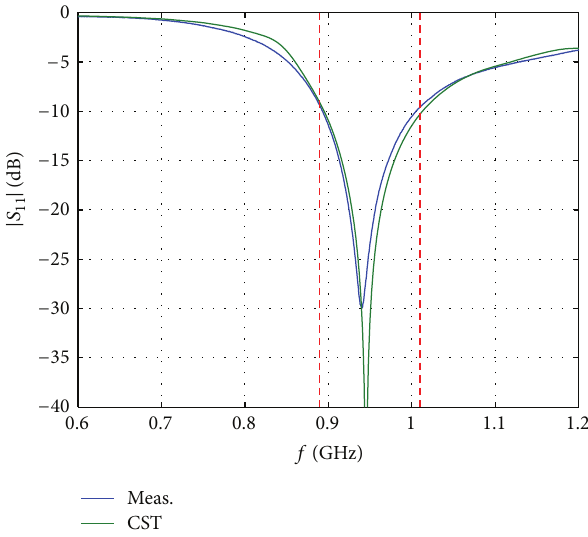
Figure 6: Antenna element matching—comparison of measured and simulated (CST Microwave Studio) input reflection coefficient at the antenna element embedded inside the 5-element antenna